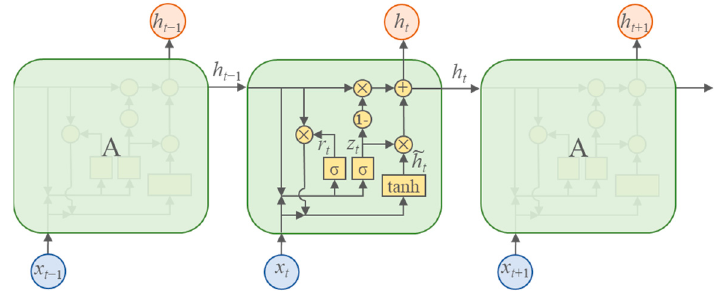
Figure 4. GRU network structure.